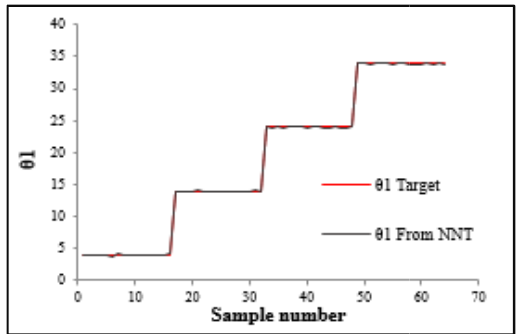
Fig. 15. The comparison between θ 1 target and ONN.